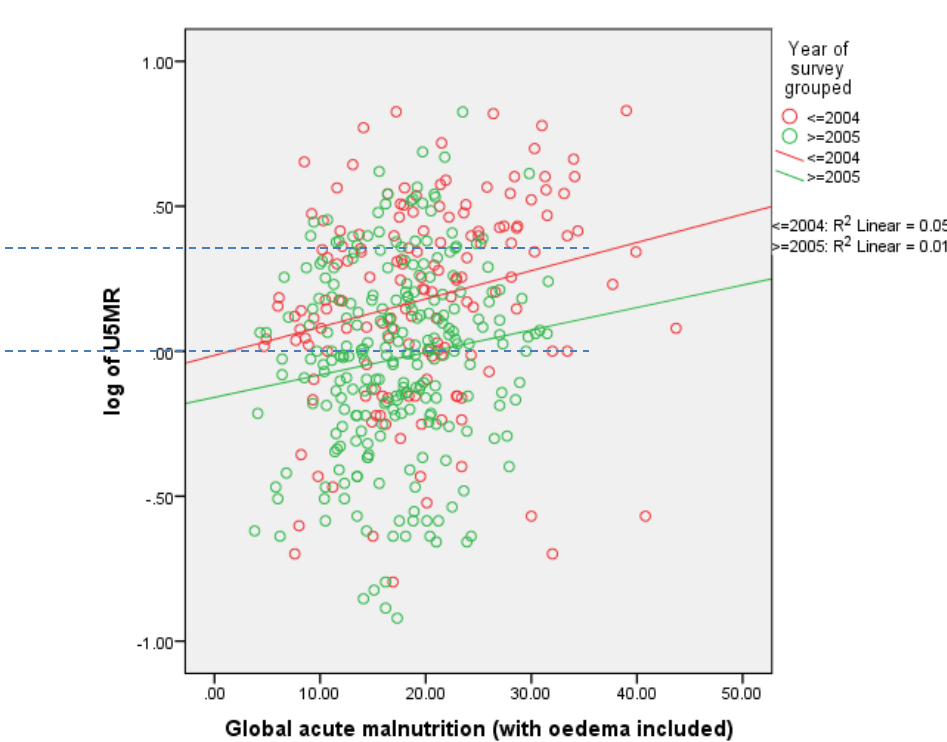
Figure 2. Associations of under-5 mortality (as log persons, resident and mixed population combined by time periods (before 2005 and after), by livelihood, in Ethiopia, Kenya, Sudan, and